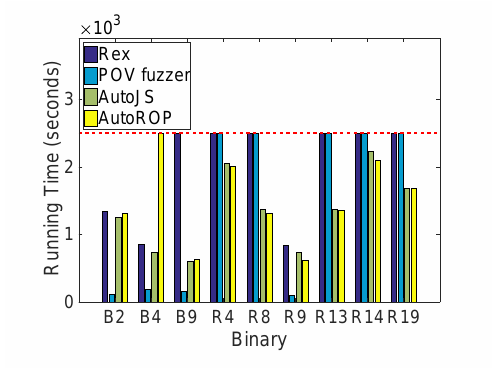
Figure 4. The running time of different vulnerability exploitation methods executed on different binary files. Each running time includes vulnerability discovery as well as exploitation time. Most importantly, those methods whose running time reaches 2.5 × 10 3 s (see dashed red line) are deemed unfit with respect to the corresponding binary file.